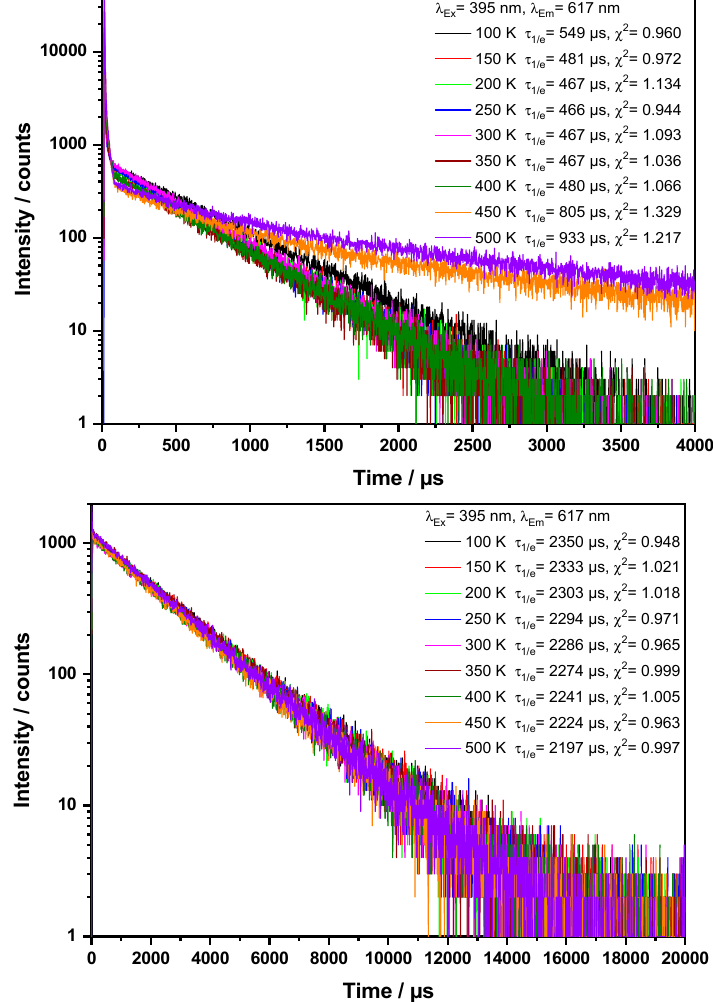
Figure 17. Temperature-dependent decay curves of NaY[SO 4 ] 2 ∙ H 2 O:Eu 3+ ( top ) and NaY[SO 4 ] 2 :Eu 3+ ( bottom ) between 100 and 500 K upon 395 nm excitation.